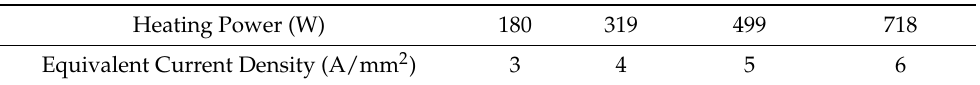
Figure 5. Thermocouple arrangement in a radial section (not drawn to scale). Table 1. The conversion relationship between the equivalent current density and heating